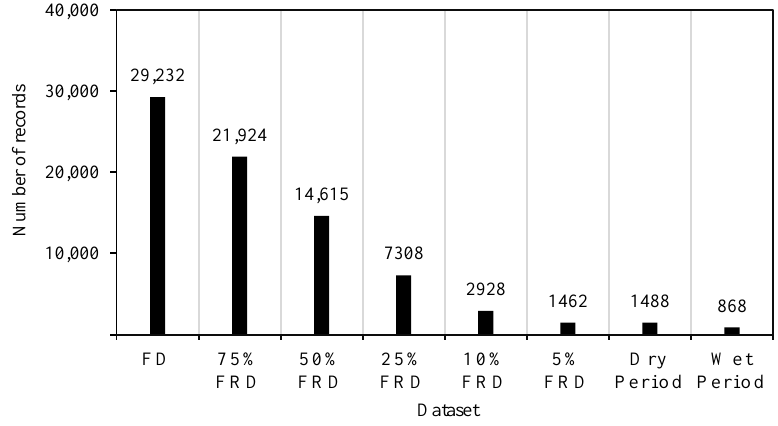
Figure 4. Record numbers per (partial) dataset.